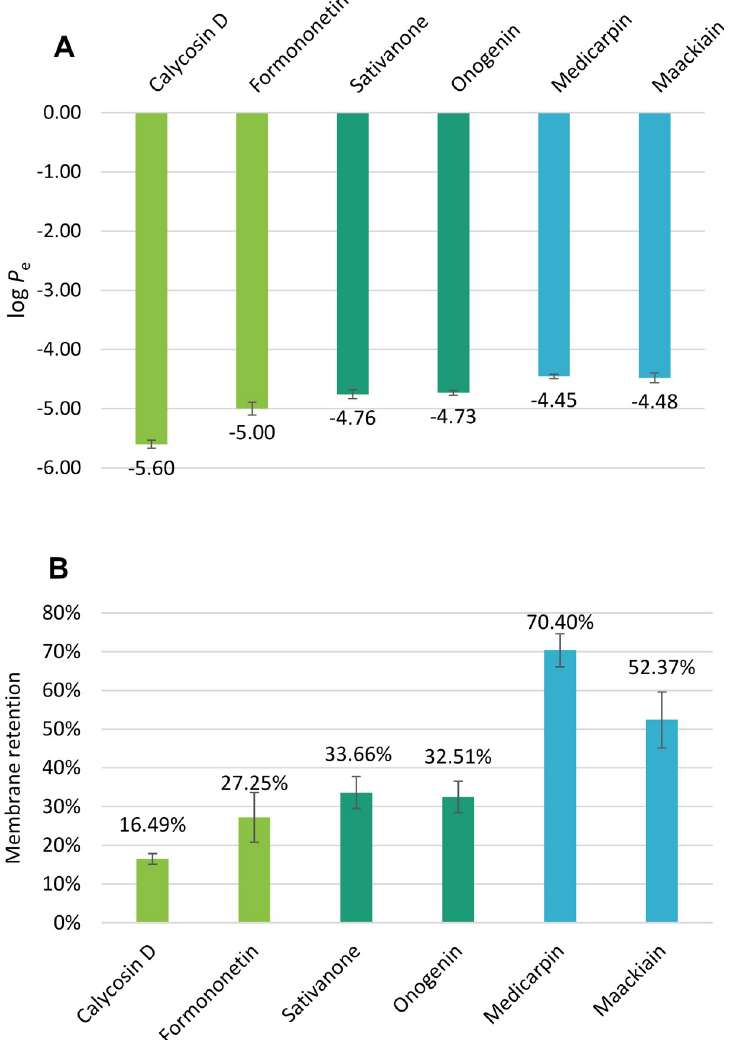
Fig 3. Experimental log P e values (A) and membrane retention (B) of the six isoflavonoid compounds (bright green: isoflavones, deep green: isoflavanones, bright blue: pterocarpans). https://doi.org/10.1371/journal.pone.0265639.g003 Table 2. Suggested physicochemical property ranges for increasing the potential for BBB penetration and physicochemical features of the six isoflavonoid aglycones.